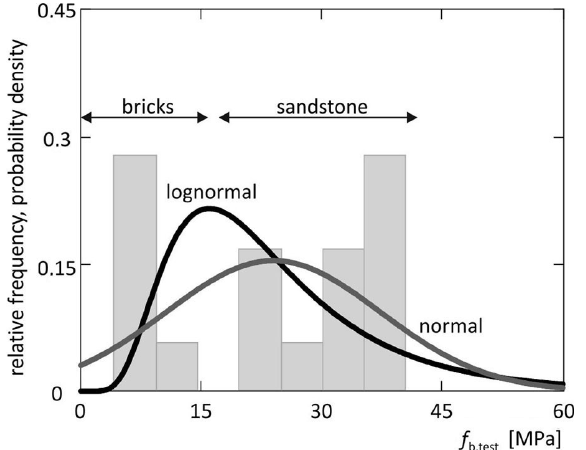
Fig. 9. Histogram of the strength of masonry units obtained by a press and fitted lognormal and normal distributions (alt. B)